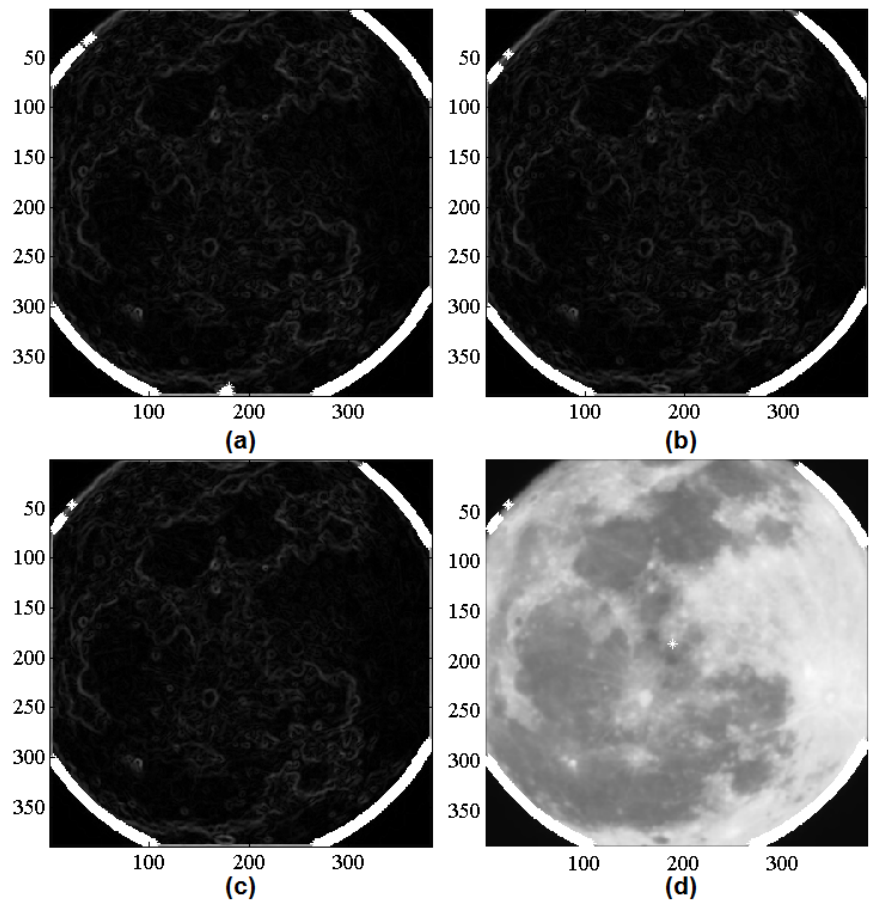
Figure 10. Example 1: Image processing phases (data in pixel). ( a ) 1490 highest derivatives; ( b ) 21 × 21 box approach removed 375 outliers; ( c ) RANSAC removed 5 outliers using 100 = 4 ; ( d ) Body center inside image. Row center = 185.5991, Column center = tests and d min 187.339, Radius = 218.0337 (worst residual = 2.9321).